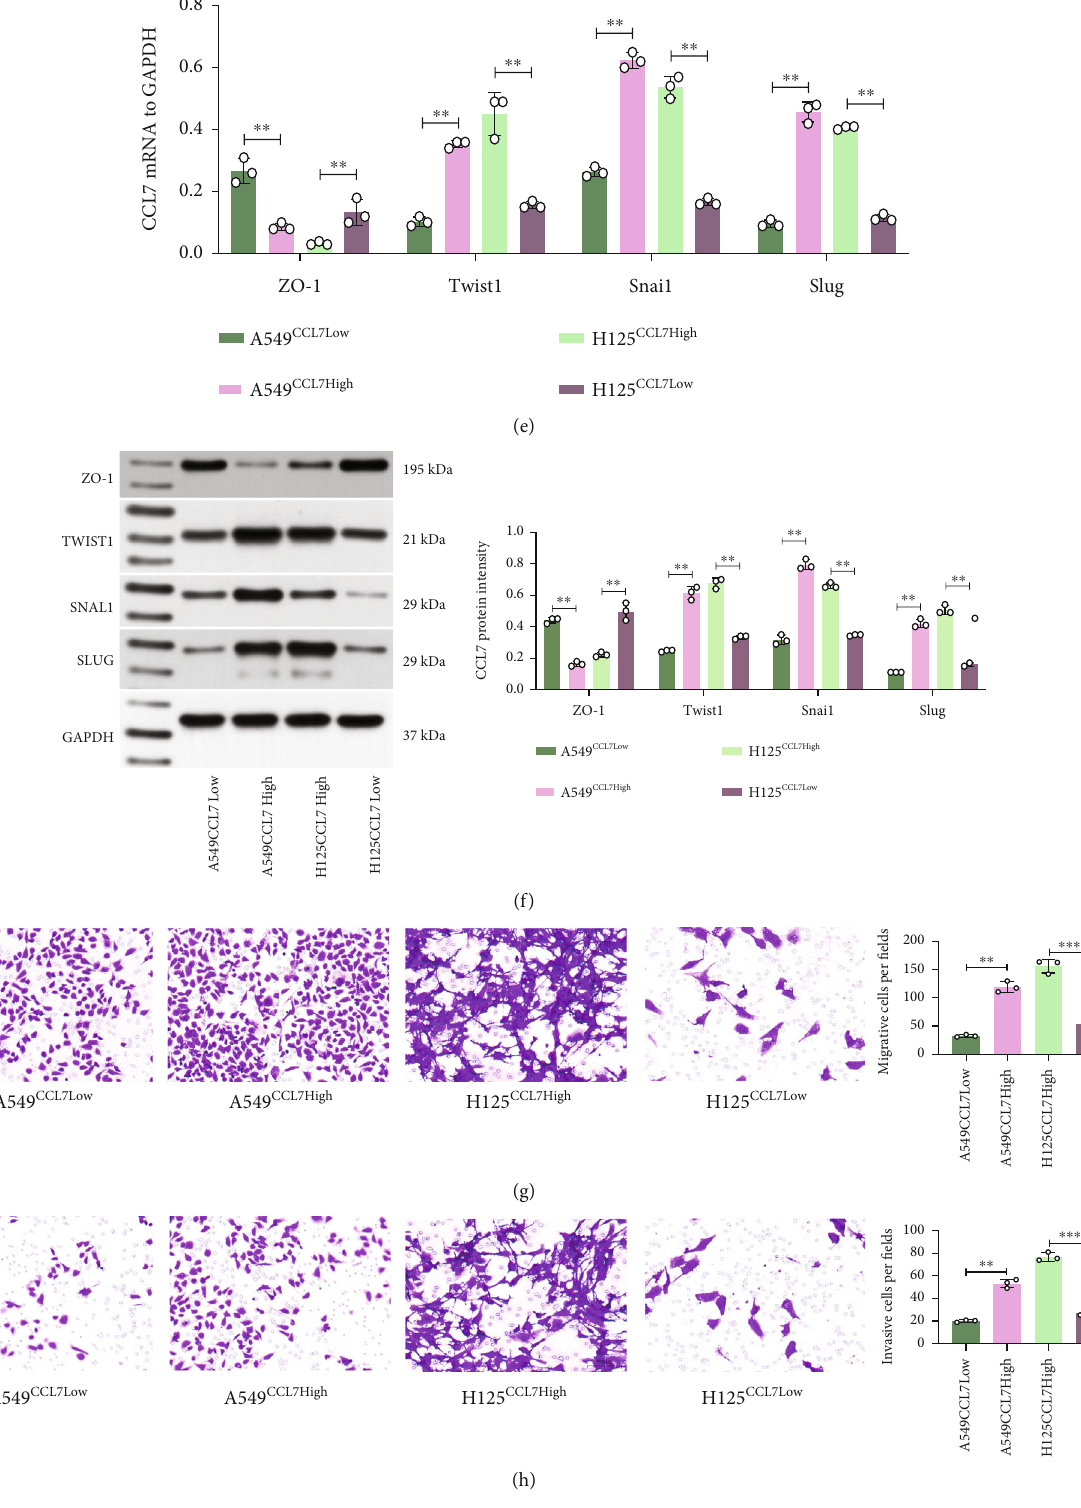
Figure 2: CCL7 knockdown suppresses EMT and mobility of LUAD cells. mRNA (a) and protein (b) levels of CCL7 in H1299, A549, H358 (low- invasive), and H125 (high-invasive) cells detected by qPCR and WB analyses; mRNA (c) and protein (d) levels of CCL7 in A549 and H125 cells after overexpression plasmid or shRNA transfection determined by qPCR and WB analyses; mRNA (e) and protein (f) levels of epithelial marker ZO-1 and mesenchymal markers Twist1, Snai1, and Slug in A549 and H125 cells examined by qPCR and WB analyses; (g) 24-h migration rate of A549 and H125 cells analyzed by the scratch test; (h) invasiveness of A549 and H125 cells analyzed by Transwell assay. Repetition = 3 . ∗∗ p < 0 : 01